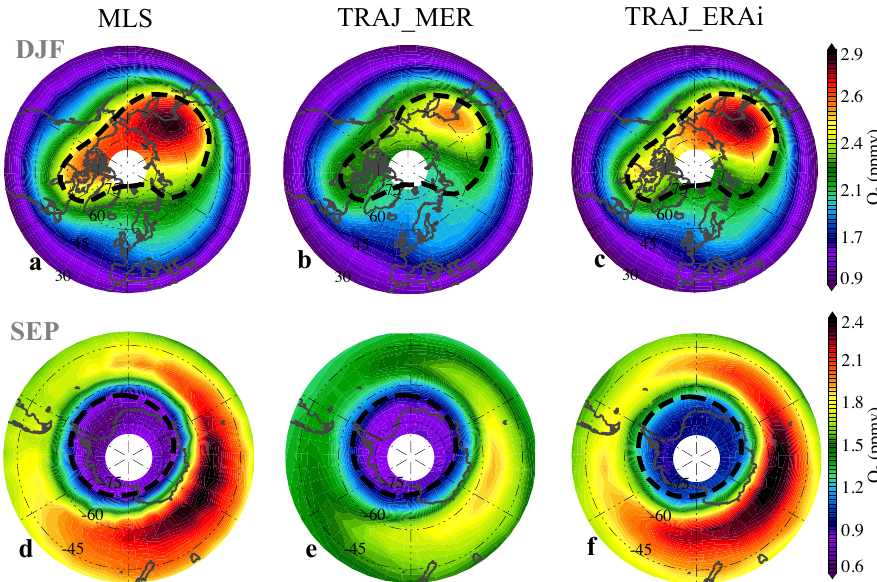
Figure 7. Polar O 3 distributions shown in MLS (left column), trajectory results driven by MERRA (middle column), and trajectory results driven by ERAi (right column) during Northern Hemisphere winter (DJF, a–c ) and Southern Hemisphere spring (September, SEP, d–f ) at 68hPa. Trajectory results are weighted by the MLS averaging kernels. The 24PVU potential vorticity level ( a–c ) and the 195K temperature ( d–f ) are overlaid in black dashed lines for DJF and SEP, respectively.